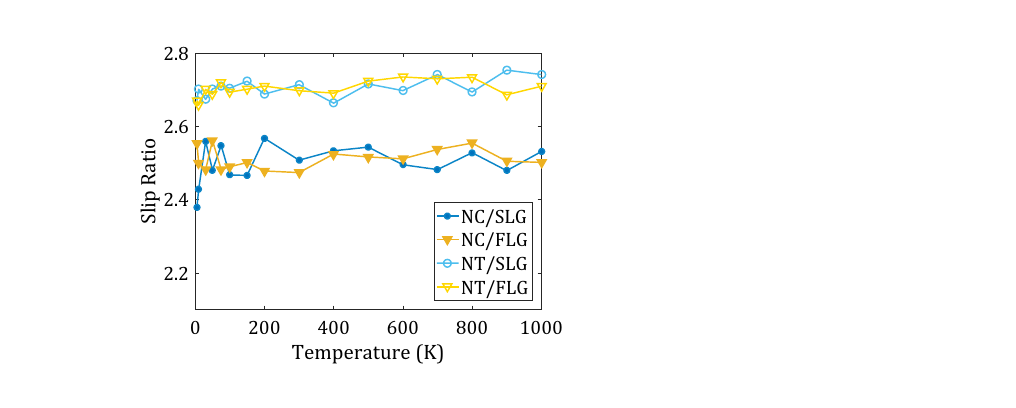
Figure 9. Quantification of the rotation of wheels: ( a ) Arrhenius plot of diffusion coefficient for wheels rolling in Nanocar and Nanotruck on two substrate types (SLG—blue, FLG—yellow); ( b ) activation energies computed for all systems.